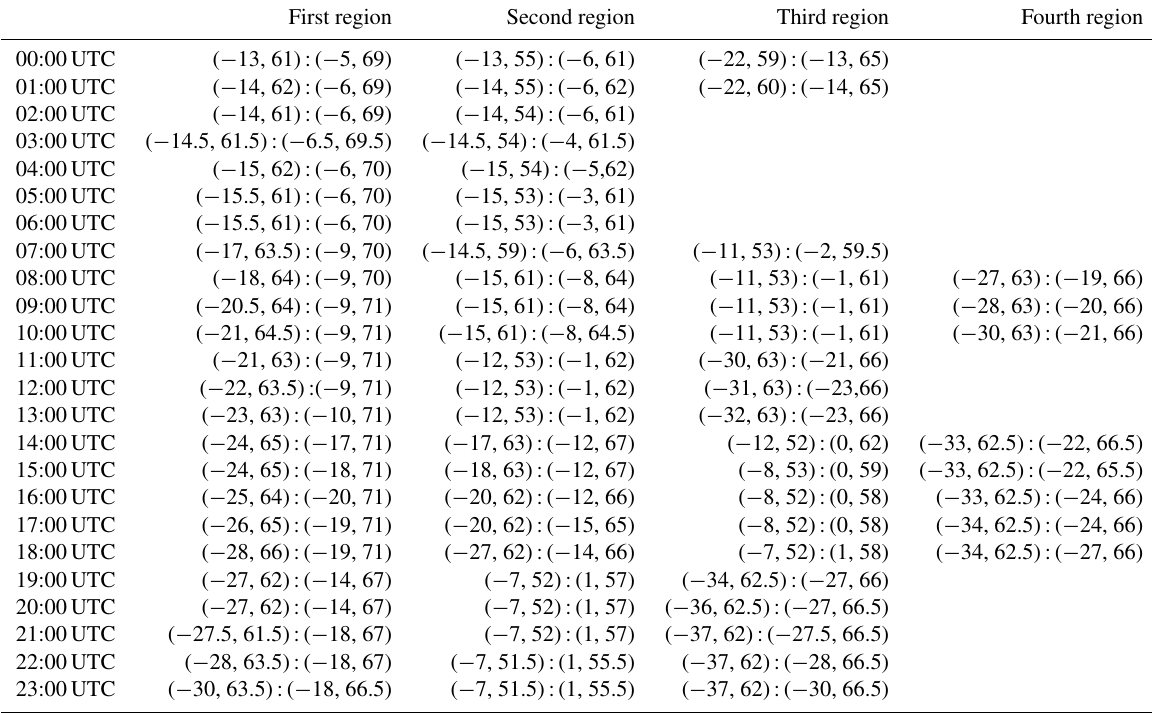
Table 3. Location of geographical regions used for comparison for each hour by longitude and latitude of the region corners. First region Second region Third region Fourth